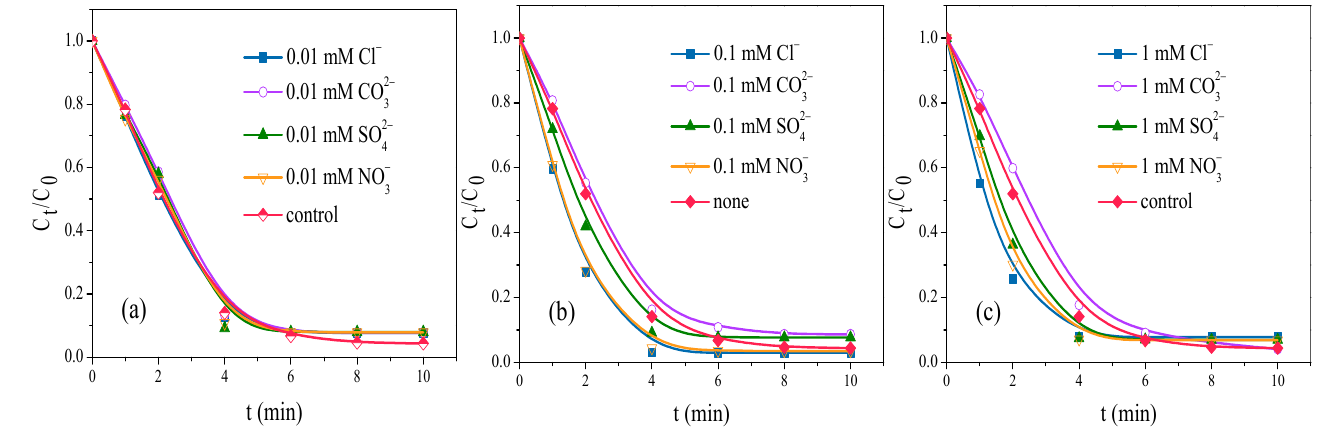
Figure 6. The effects of coexisting anions at 0.01 mM ( a ), 0.1 mM ( b ), and 1 mM ( c ) on the decolorization of Orange ([Fe 3+ ] 0 = 100 µM, [Orange II] 0 = 50 µM, [PMS] 0 = 150 µM, [oxalate] 0 = 80 µM, under UVA irradiation, λ irr. = 365 nm, pH 3). Table 1. k obs in the UVA-Fe 3+ -PMS-oxalate system in the presence of different coexisting anions at different